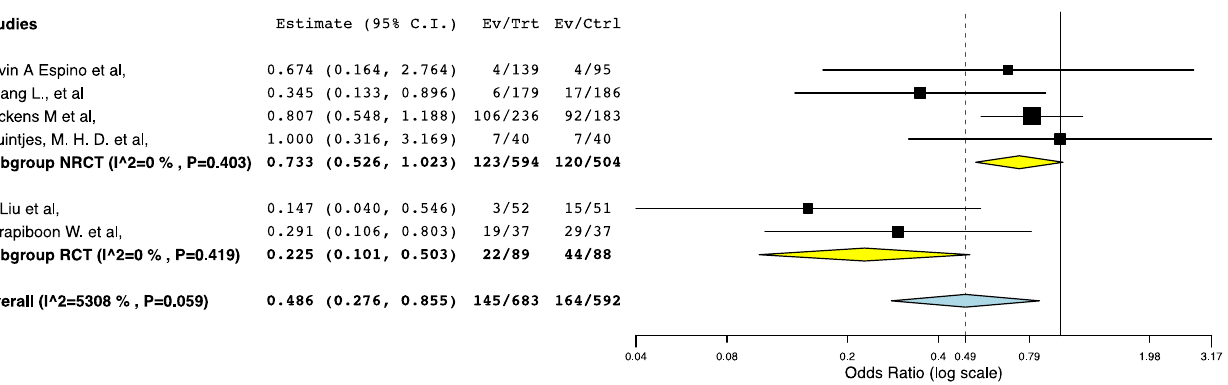
Figure 12. Forest plot: subgroup meta-analysis. (ERAS—traditional perioperative care).